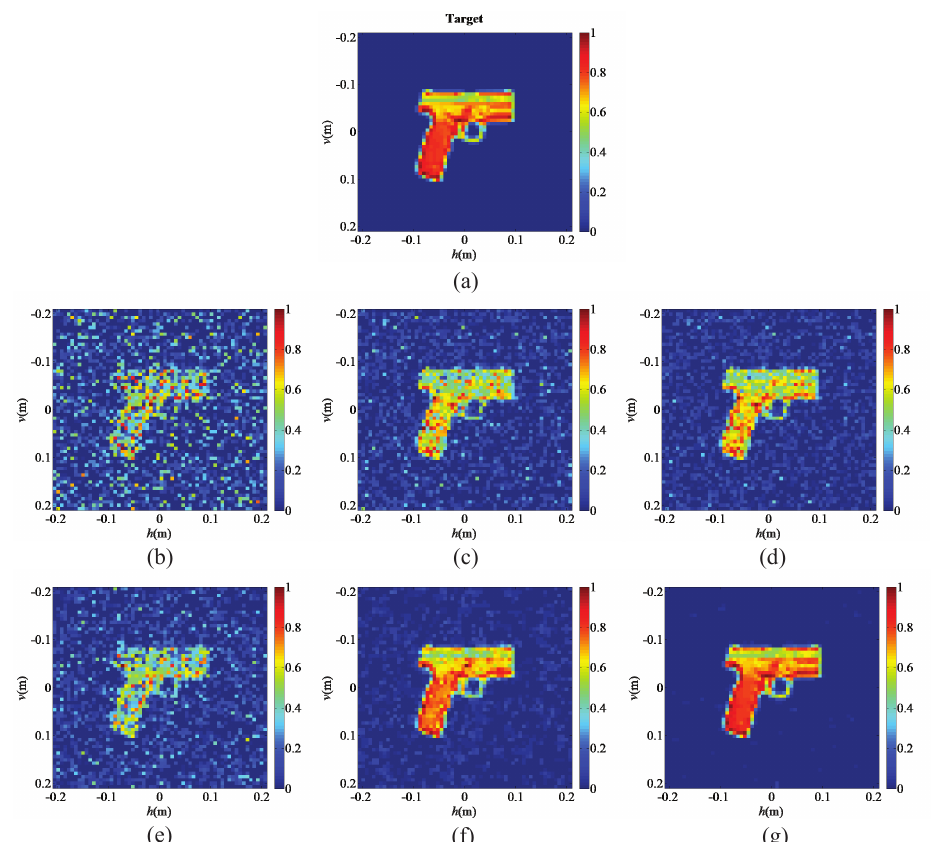
Figure 8. Reconstruction results for extended target with TVAL3 algorithm under different SNRs: